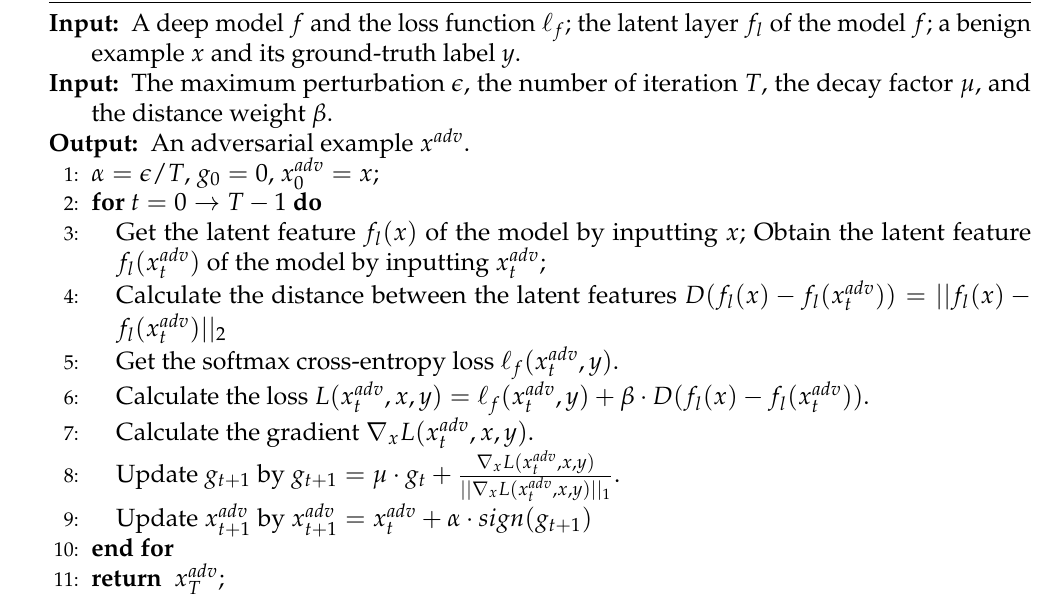
Algorithm 1 Distance Metric